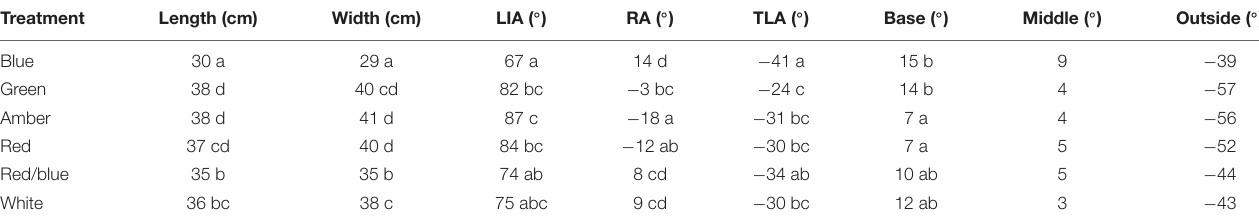
TABLE 1 | Effects of spectral composition on leaf architecture. Treatment